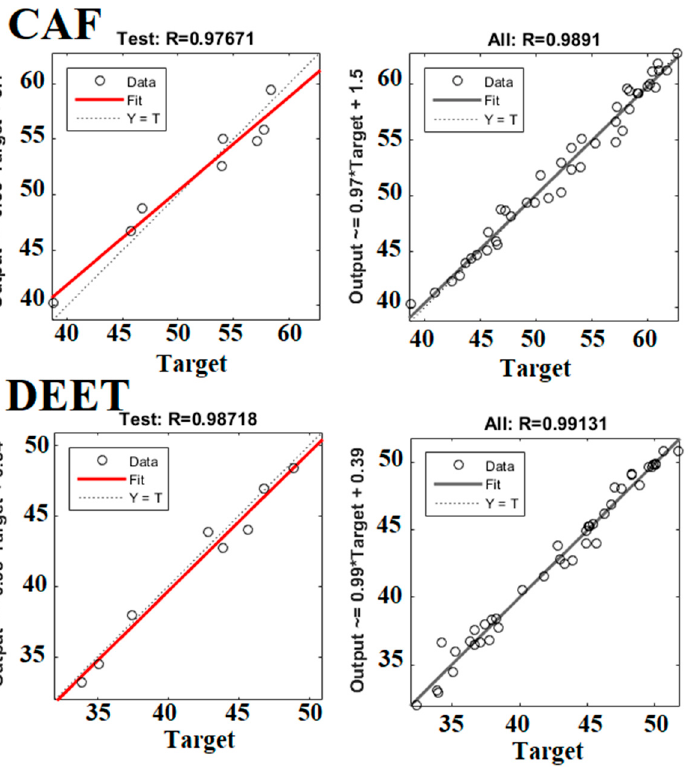
Figure 5. Prediction and experimental values for the optimum analysis of the test and all data for the elimination of CAF and DEET in reactor 2. elimination of CAF and DEET in reactor